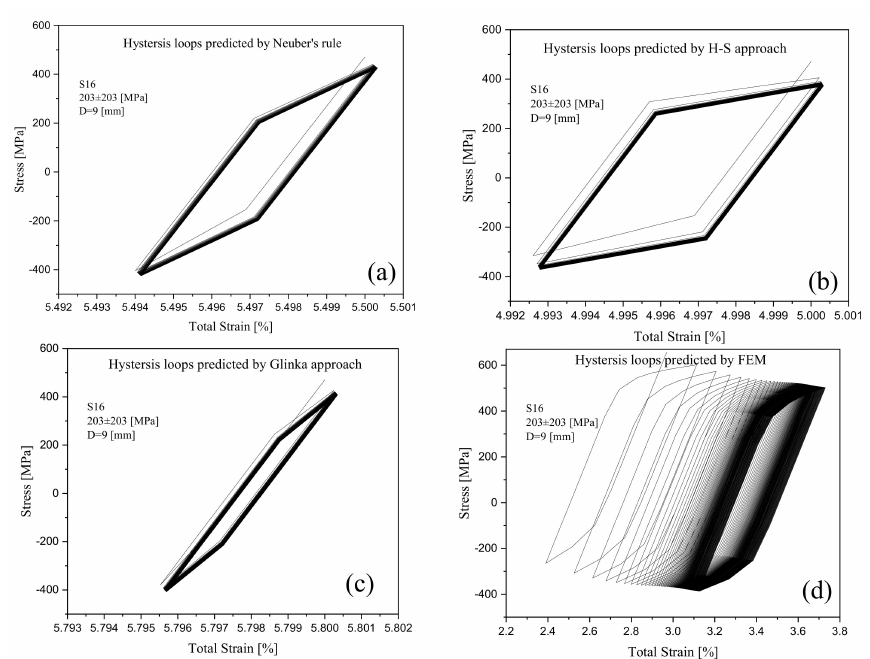
Figure 10. ( a – c ) Predicted stress-strain hysteresis loops based on Neuber’s rule, H-S rule, and Glinka’s approach coupled with the A-V model, respectively, and ( d ) simulated stress-strain hysteresis loops by FE analysis on the basis of Chaboche’s model.